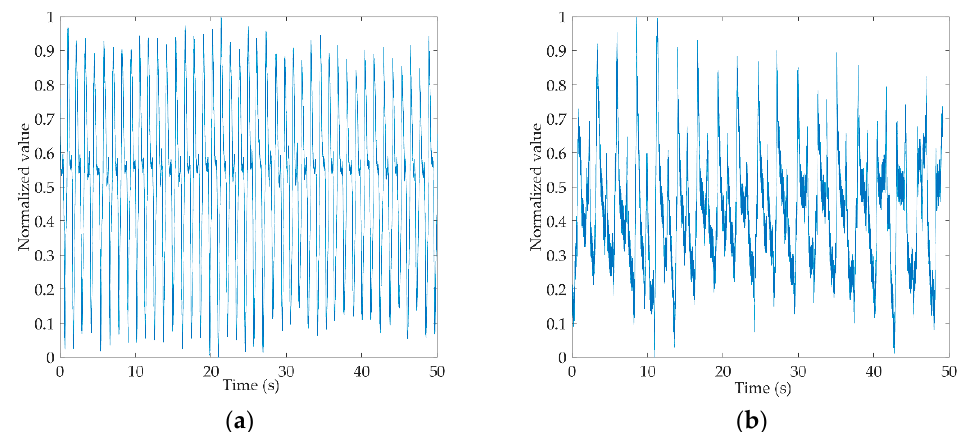
Figure 3. Schematic diagram of the original electrostatic gait signal. ( a ) Preprocessed electrostatic gait signals of a healthy control; ( b ) Preprocessed electrostatic gait signals of a hemiplegic patient.